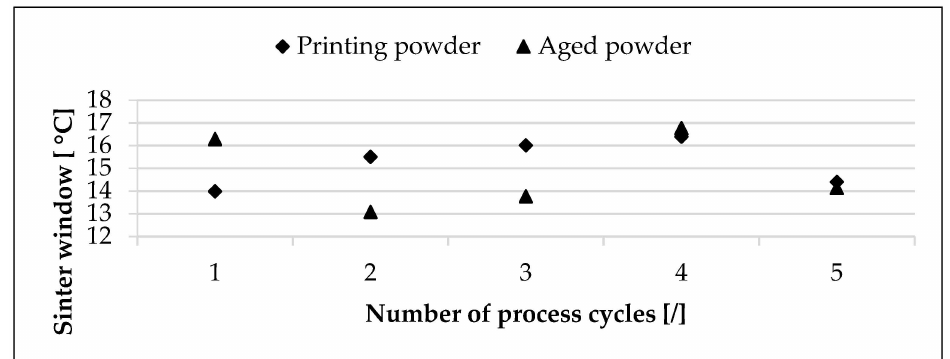
Figure 9. Influence of cyclic reuse on the sinter window of the used polyamide 12 sinter material. The sinter window was determined from the difference between onset melting and onset crystallization temperature. Five process cycles were considered. The printing powder and the aged powder were analyzed. The refresh rate was 30 wt%.